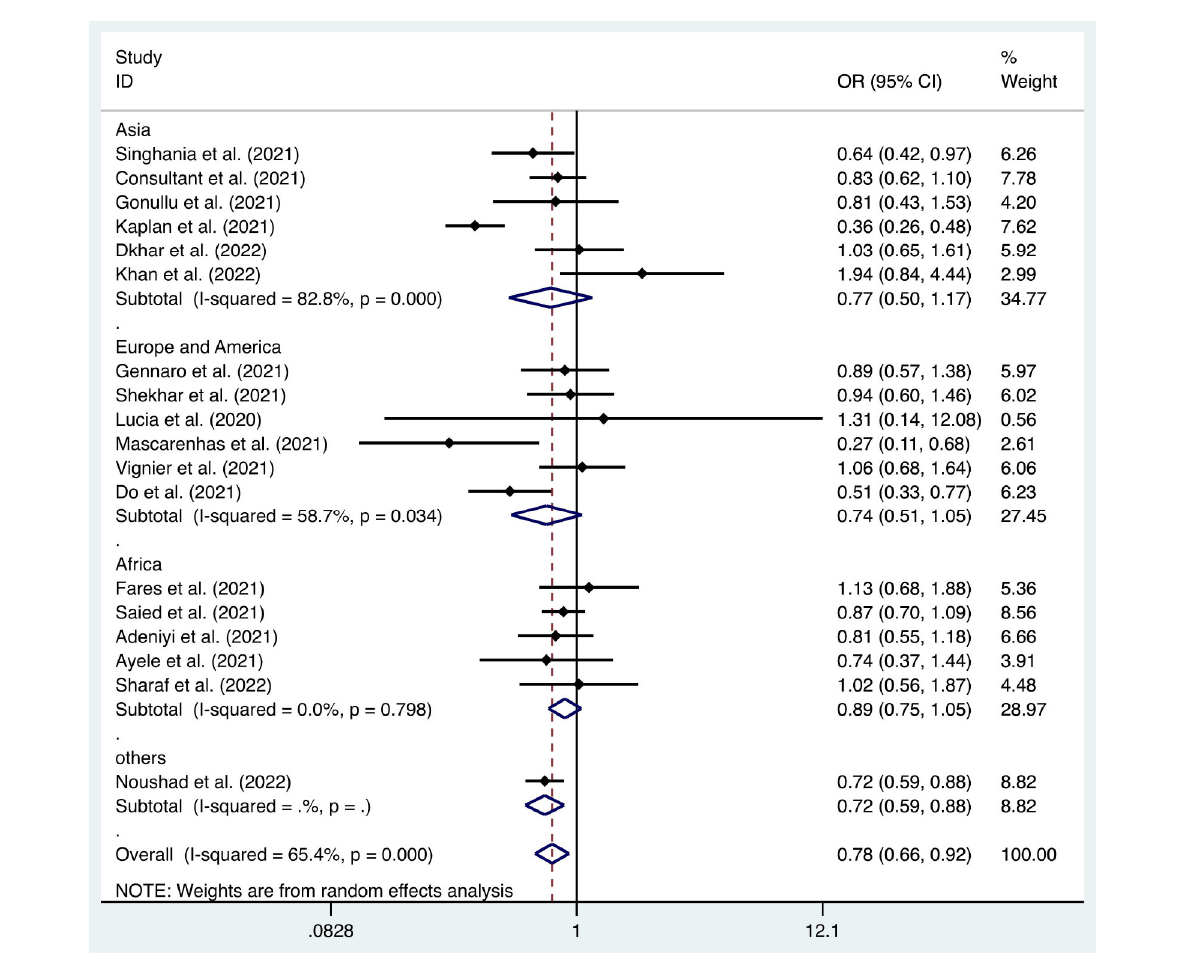
FIGURE10 Forest plot of the relationship between healthcare workers’ acceptance of the coronavirus disease 2019 vaccination and the infection rate of severe acute respiratory syndrome coronavirus 2.